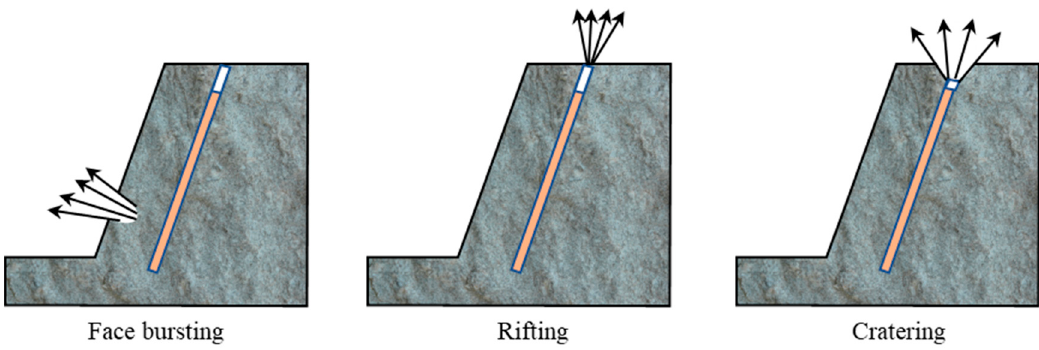
Figure 9. Main categories of flyrock in open-pit mines.